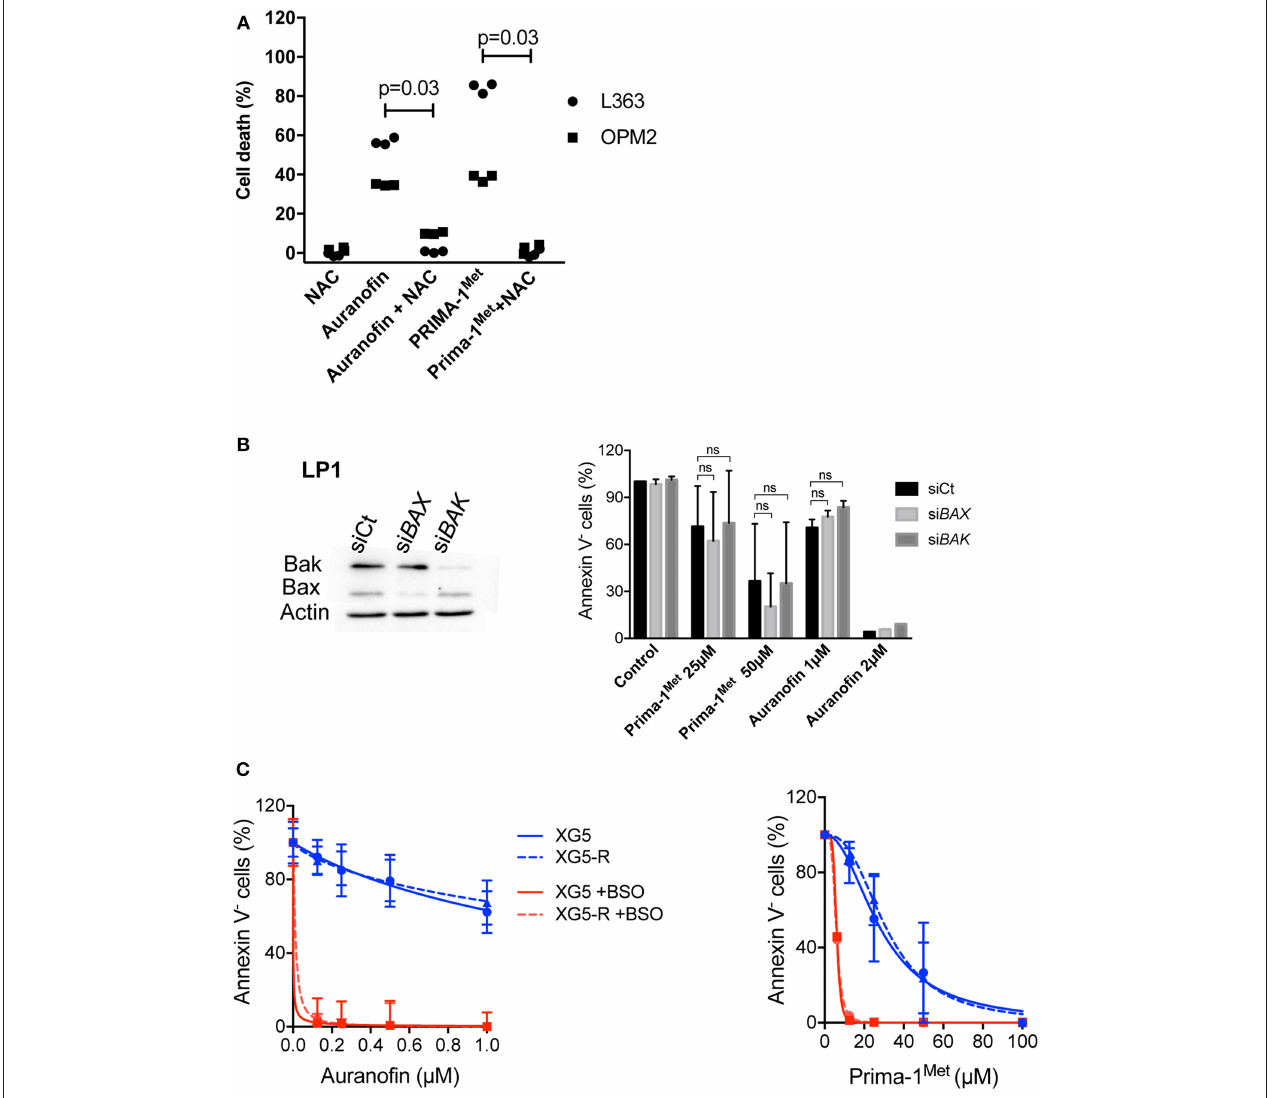
FIGURE 2 | Auranofin and Prima-1 Met induced ROS-dependent BAX/BAK-independent cell death. (A) L363 and OPM2 cell lines (500 000 cells/ml) were incubated for 2 days with auranofin (2000 and 1000nM, respectively) or Prima-1 Met (80 and 40 µ M, respectively) with or without NAC (0.5mM). Cell death was assessed by Annexin V staining. The data represent 3 independent experiments. The statistical analyses were performed using the Wilcoxon matched-pairs signed-rank test. (B) LP1 cells were transfected with siRNA against BAX or BAK1 for 2 days and sensitivity to each drug was assessed. The statistical analyses were performed using the two-way ANOVA test with multiple comparisons. (C) Auranofin and Prima-1 Met LD 50 values were determined in XG5 parental cells and in venetoclax resistant XG5-199R cells. Cells were incubated with increasing concentrations of auranofin or Prima-1 Met with or without 500 µ M BSO for 2 days, and cell death was assessed by Annexin V